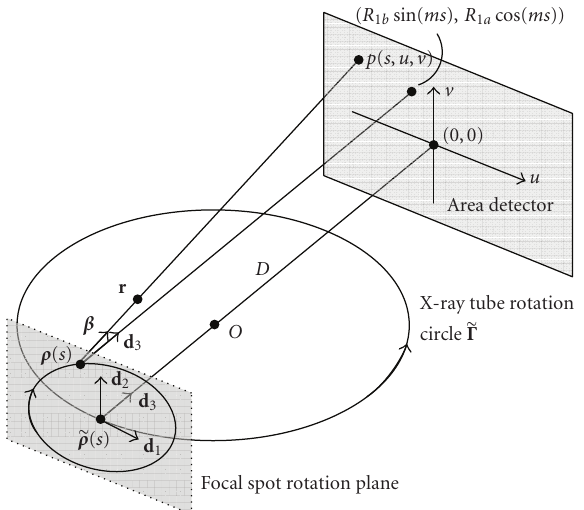
Figure 4: Local coordinate system with the composite-circling scanning trajectory.